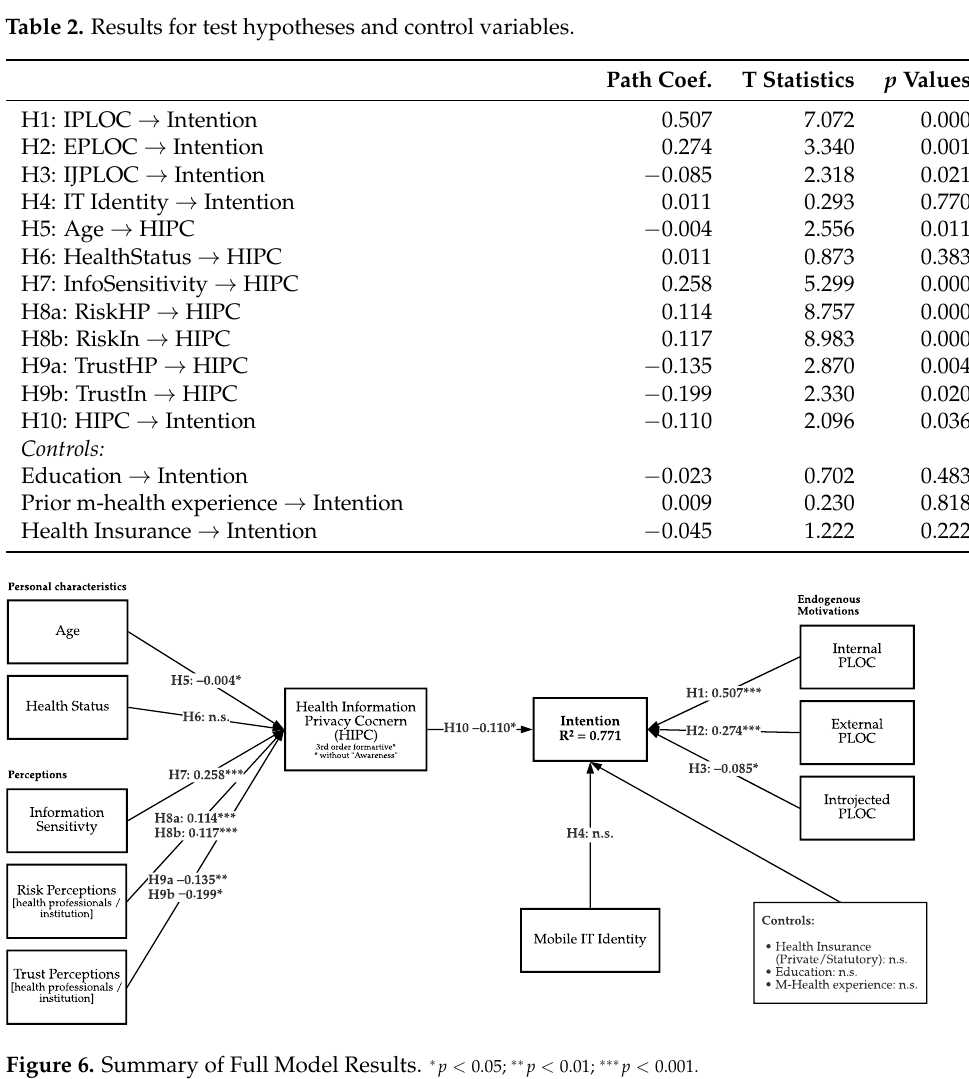
Figure 6. Summary of Full Model Results. ∗ p < 0.05; ∗∗ p < 0.01; ∗∗∗ p <